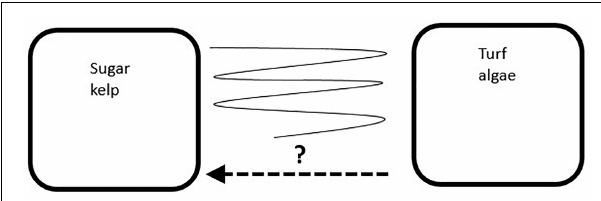
community dominated by ephemeral turf algae: The turf algae dominance may persist for several years (right box), the turf algae sites might recover to sugar kelp dominance (arrow toward the left box), or the sites might fluctuate between years with dominance of either of the two groups (illustrated by the fluctuating line between the two